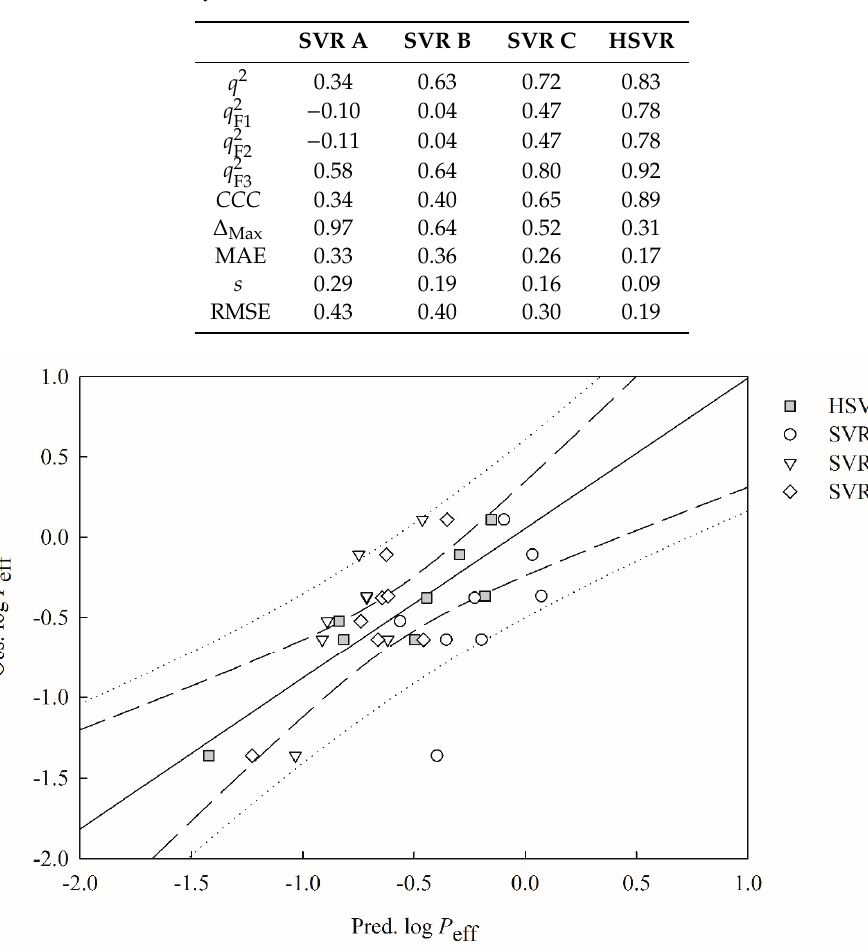
Figure 4. Observed log P eff vs. the log P eff predicted by SVR A (open circle), SVR B (open triangle), HSVR SVR C (open diamond), and HSVR (gray square) for the molecules in the outlier set. The solid line, dashed lines, and dotted lines correspond to the HSVR regression of the data, 95% confidence intervals for the HSVR regression, and 95% confidence interval for the prediction, respectively.